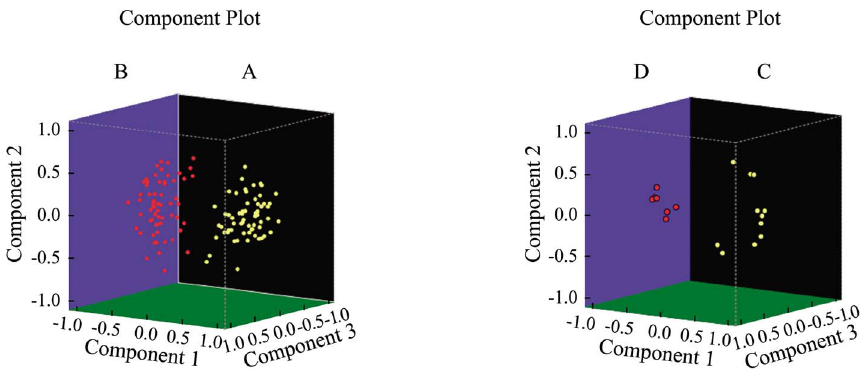
Figure 7. Three-dimensional plot of the principal components of samples and indexes,respectively. (A) Disease group. (B) Control group. (C) The up-regulated peaks. (D) The down-regulated peaks.